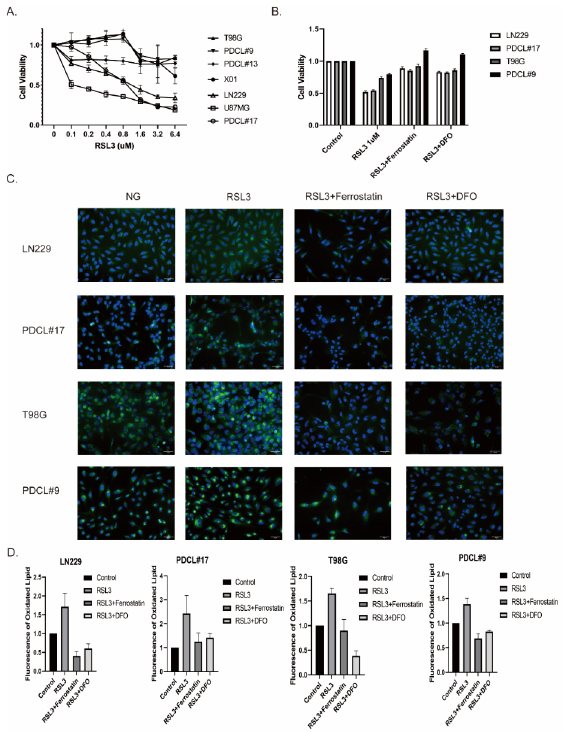
Figure 1. RSL3-induced ferroptosis-like cell death in glioblastoma cell lines. ( A ) Glioblastoma cell lines were treated with increasing doses of RSL3 (0 µ M, 0.1 µ M, 0.2 µ M, 0.4 µ M, 0.8 µ M, 1.6 µ M, 3.2 µ M, and 6.4 µ M), cell viability was assessed by MTT assays. Cell lines A1G1, T98G, PDCL#9, PDCL#13, and X01 showed only a mild reduction in cell viability, whereas LN229, U87MG, and PDCL#17 exhibited a significant reduction. ( B ) RSL-3-sensitive LN229 and PDCL#17 cells, and RSL-3 resistant T98G and PDCL#9 cells were treated with RSL3 combined with ferroptosis inhibitor ferrostatin and iron chelation DFO; cell viability was determined by MTT assays. Both ferrostatin and DFO completely abolished the RSL-3 induced cell death. ( C , D ) RSL-3-sensitive LN229 and PDCL#17 cells, and RSL-3-resistant T98G and PDCL#9 cells were treated with RSL3, combined with ferrostatin and DFO, respectively; lipid peroxidation (LPO) induced by RSL3 treatment was determined using BODIPY C11-581/591 reagent, as shown by green fluorescence. Results are quantified in ( D ) ( p -values: untreated control vs. RSL3 < 0.005, RSL3 vs. RSL3 + ferrostatin < 0.005, RSL3 vs. RSL3 + DFO < 0.005). All cell lines showed pronounced induction of LPO that could be completely blocked by ferroptosis